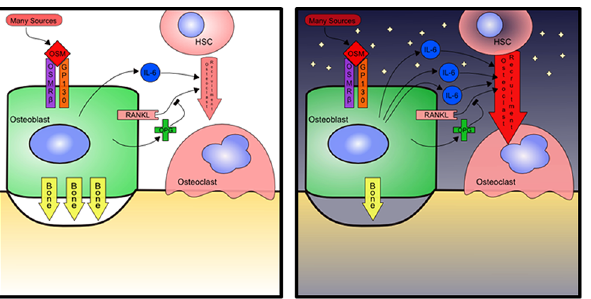
Fig 7. Summary model of microgravity and OSM promoting net bone loss. Under normal (1G) gravity conditions (left), OSM promotes osteoblast activity and stimulates osteoid production. OSM also promotes the expression of osteoblast produced IL-6 and RANKL to promote osteoclast differentiation and activity, leading to bone resorption. This activity is regulated by the production of OPG, which will inhibit RANKL- mediated effects on osteoclasts. Under microgravity conditions (right), osteoblast activity is inhibited, while the production of osteoclast activating IL-6 by the osteoblasts is increased when stimulated by OSM. Overall, osteoid formation by osteoblasts is reduced and osteoclast activity increases under microgravity, leading to net bone